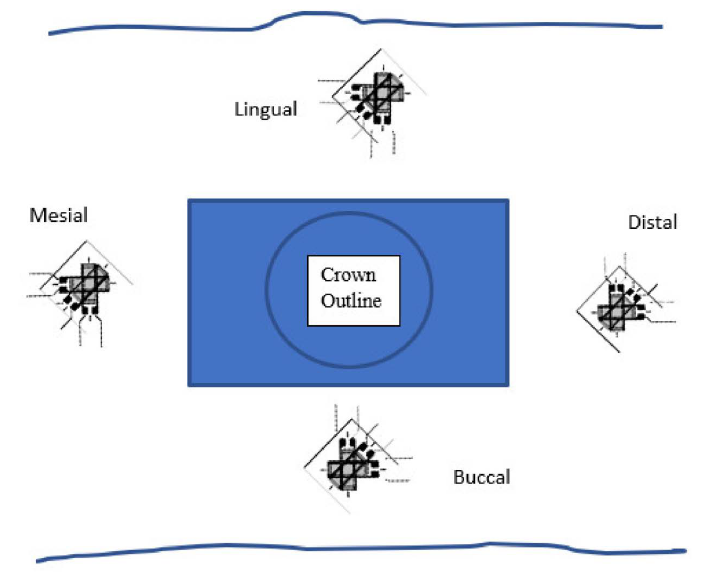
Figure 4. Strain gauge distribution: plan view. Note that this plan view does not show that the buccal and lingual gauges were “vertically oriented” with respect to the mesial and distal (crestal “horizontally oriented”)